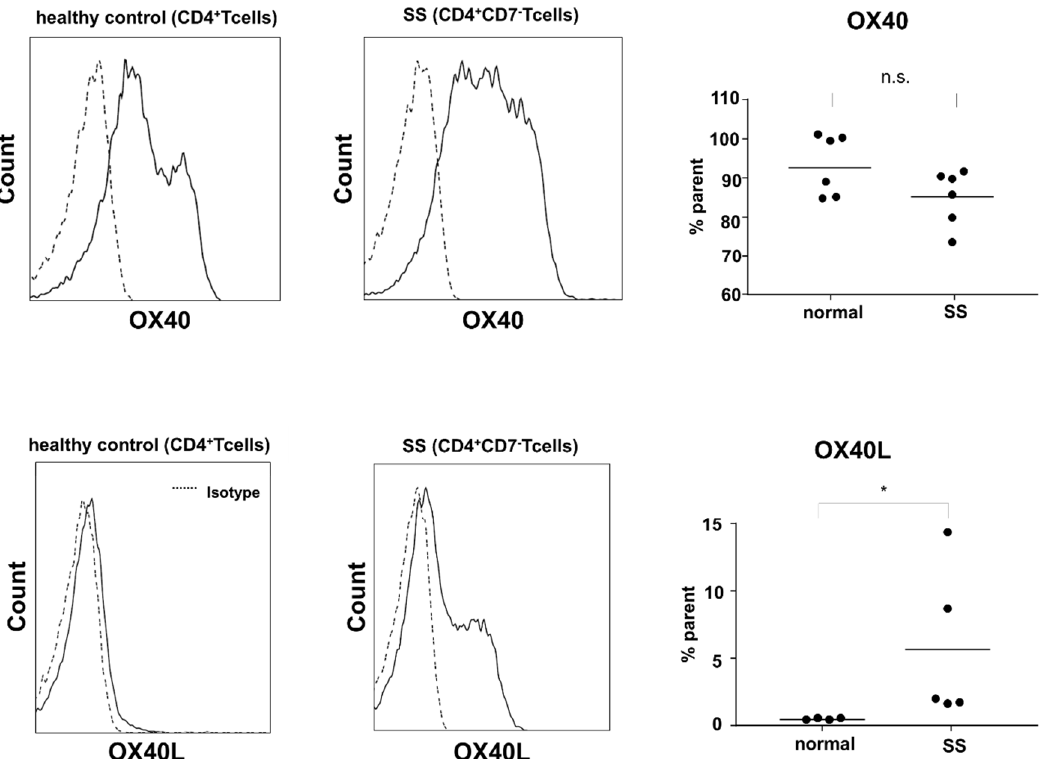
Figure 3. OX40 and OX40L expression was analyzed by flow cytometry in CD4 + CD7 − T cells from 6 S é zary syndrome (SS) patients and CD4 + T cells from 6 healthy controls. Comparison of OX40 and OX40L-positive cell ratios in peripheral blood CD4 + CD7 − T cells in patients with SS or in healthy controls peripheral blood CD4 + T cells. n.s.: not significant. * p < 0.05.